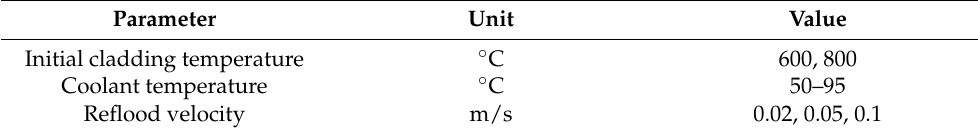
Table 2. Summary of test conditions.